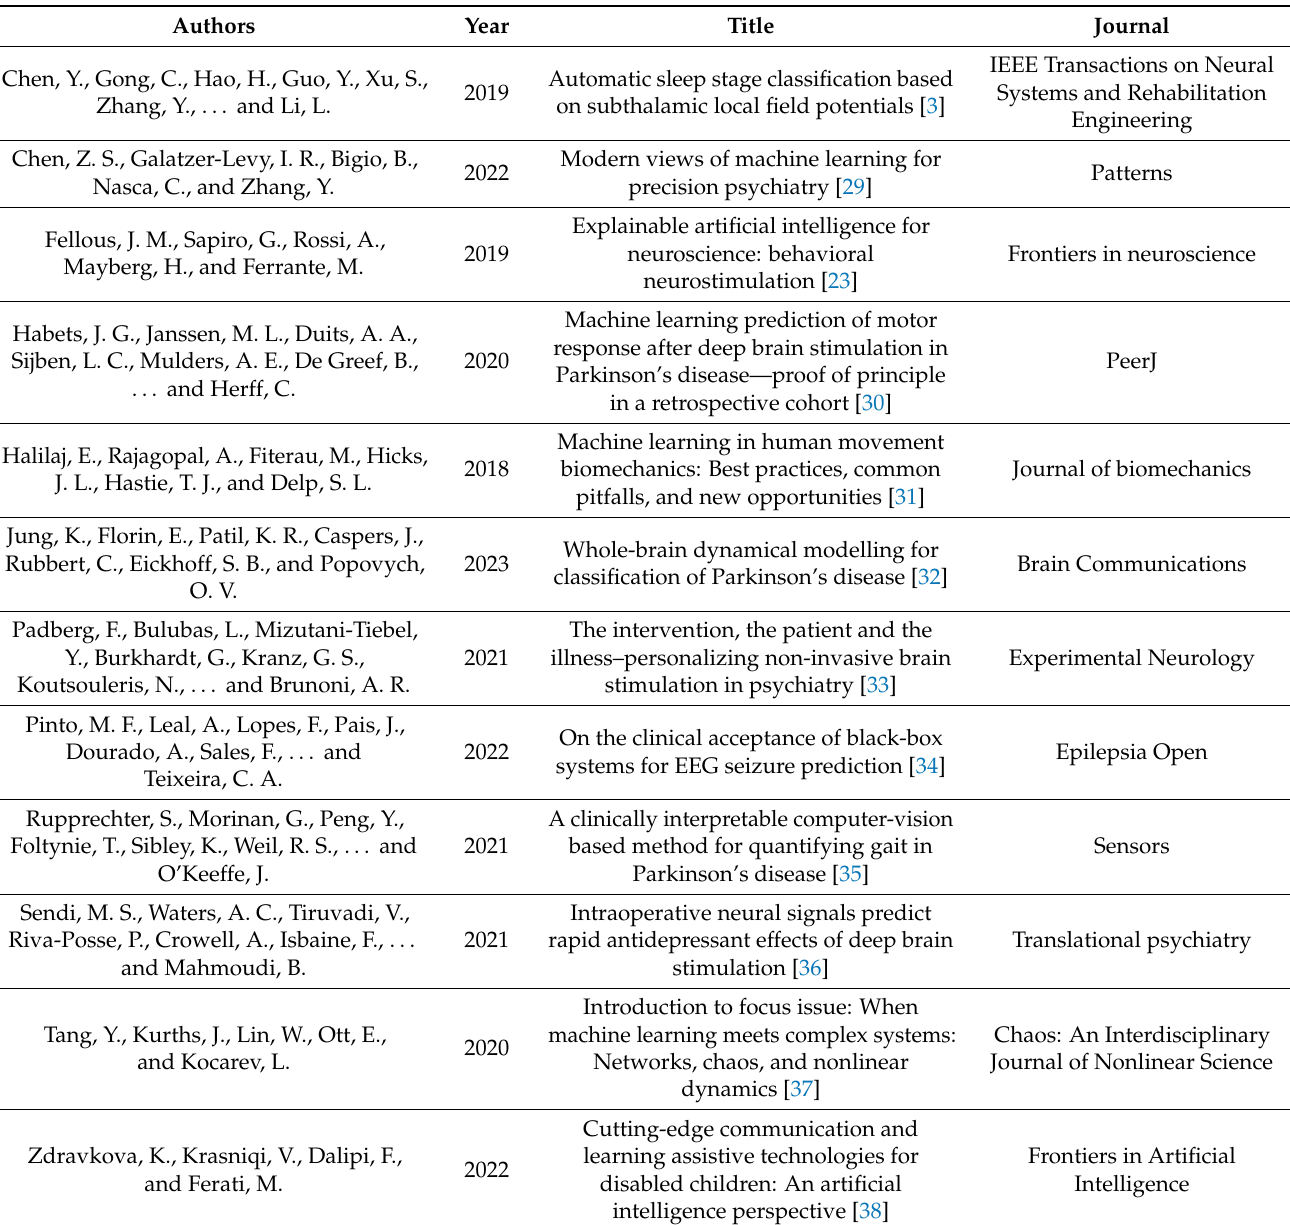
Table 1. Final corpus of journal